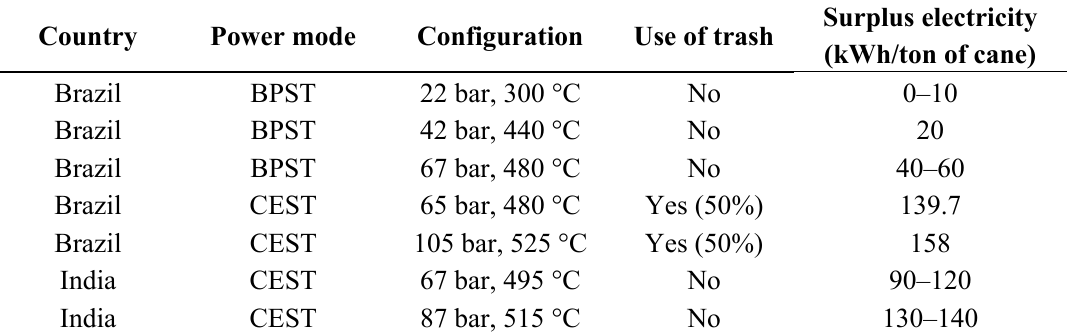
Table 1. Electricity surplus in some Brazilian and Indian sugarcane milling plants